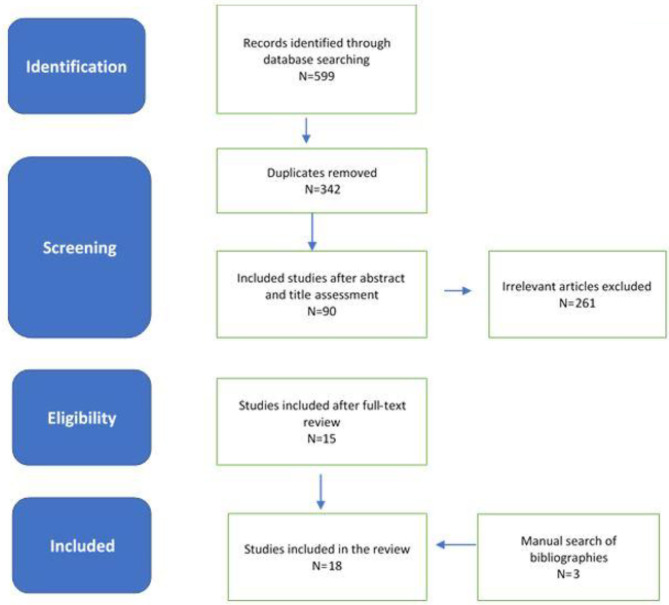
PRISMA Flowchart.